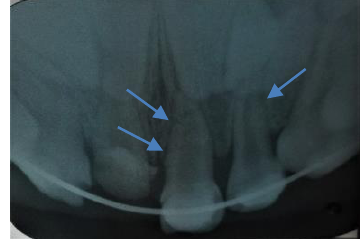
Figure 4: Periapical radiograph showing lines of root fracture in the right primary central and lateral incisors.